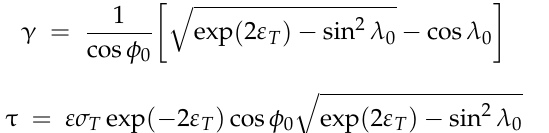
Figure 2. ( a ) The stress–strain curves of single crystal aluminum with initial orientations of [001], [111], [112], [101], [102] and [213], as obtained by the MD simulations [23]; ( b ) the corresponding experimental stress–strain curves, as obtained from tensile straining tests using single crystal copper [14].